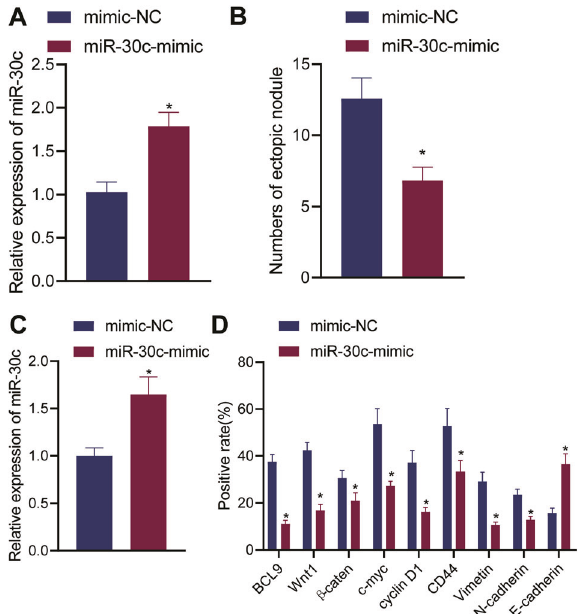
Fig. 5 miR-30c delivered by EECs-derived exosomes suppressed ecto-EEC metastasis in nude mice. A qRT-PCR measurement of the expression of miR-30c in exosomes derived from ecto-EECs treated with miR-30c-mimic; B Detection of EMs metastasis in endometrial tissues of mice on the 14th day from the intraperitoneal injection of exosomes; C qRT-PCR measurement of the expression of miR-30c in ectopic endometrial tissue of mice ( n = 12); D Immunohistochemical detection of the expression of related proteins in ectopic endometrial tissues of mice ( n = 12). Measurement data were characterized as mean±SD. The comparison between data of two groups was performed by an independent sample t -test. * p <0.05 versus the mimic-NC group.